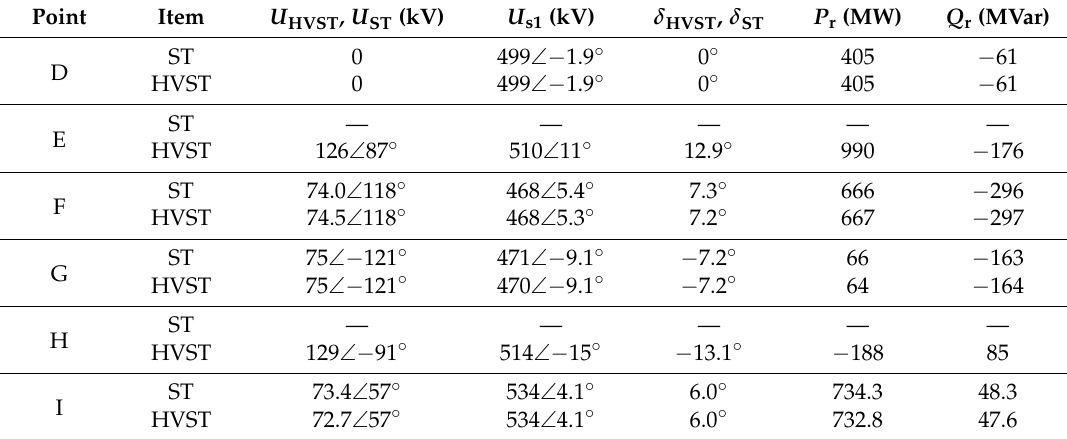
Table 3. Steady state simulation results for the ST and the HVST.